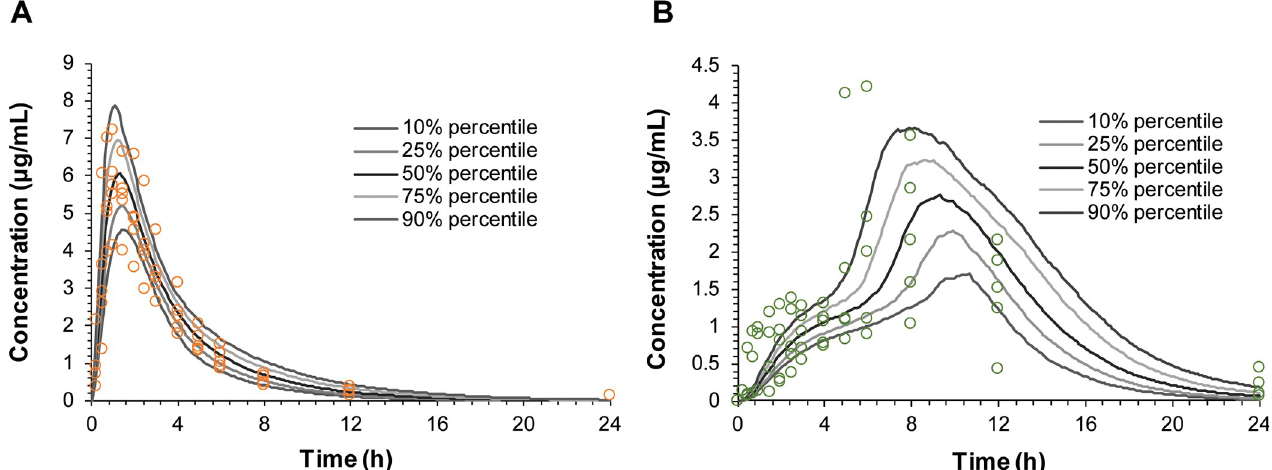
Fig 6. Visual predictive check plots of the population pharmacokinetic (POP-PK) model. Visual predictive check plots for (A) immediate-release (IR) tablet and (B) gastroretentive (GR) system for the validation of the final POP-PK model to predict in vivo dissolution profiles. The open circles represent the observed data, and the lines represent the predicted profiles obtained from final POP-PK